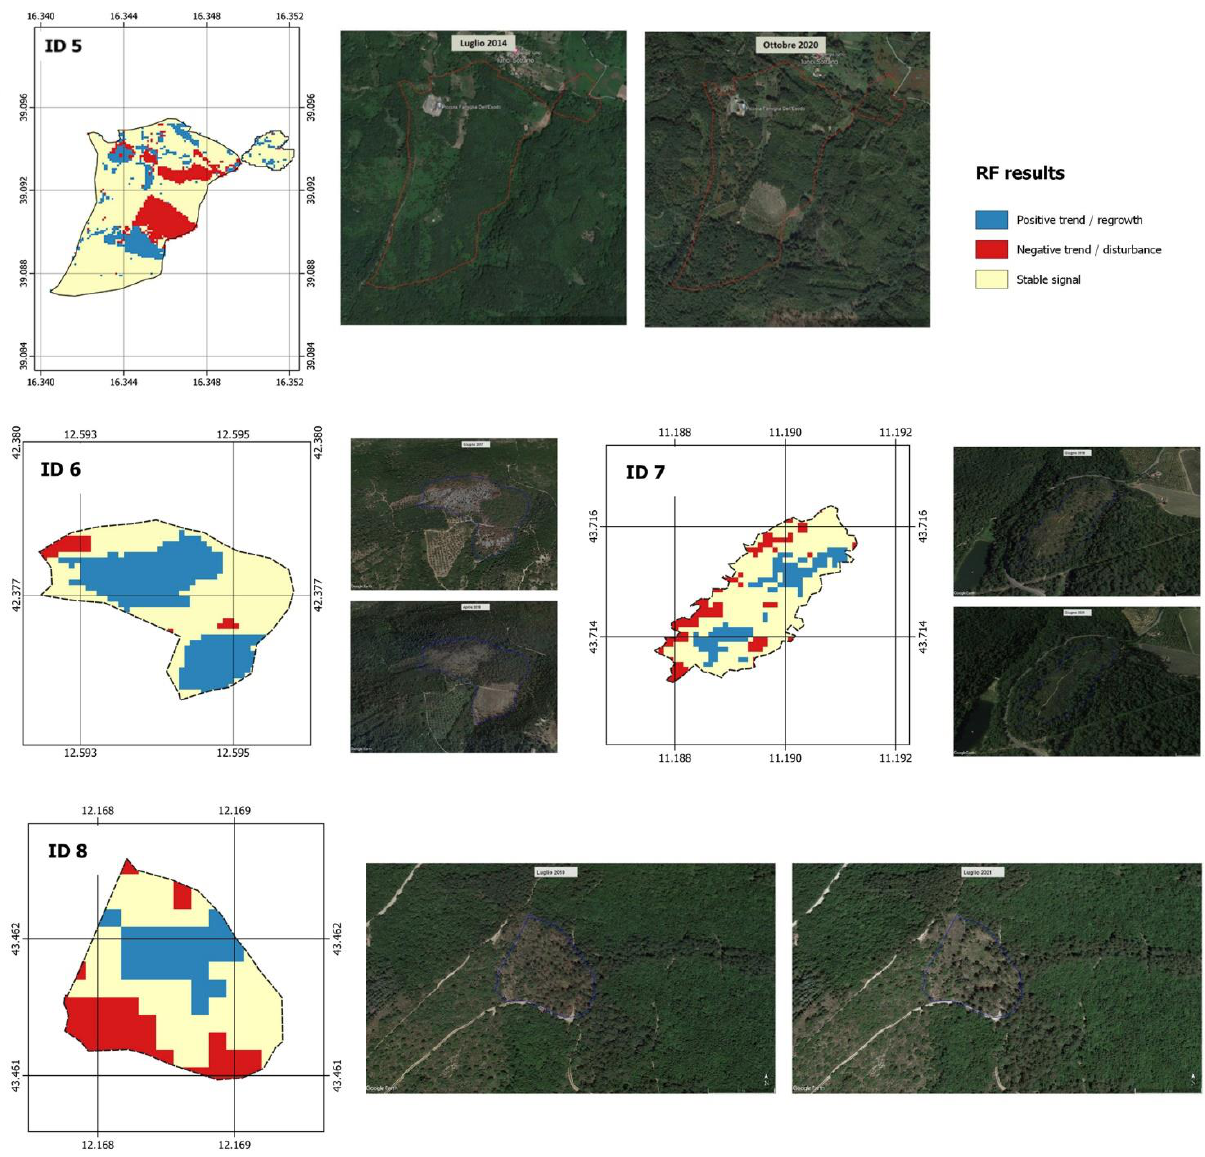
Figure 10. Events 5–8 (referring to IDs in Table 1) and comparison with high-resolution images from Google Earth.